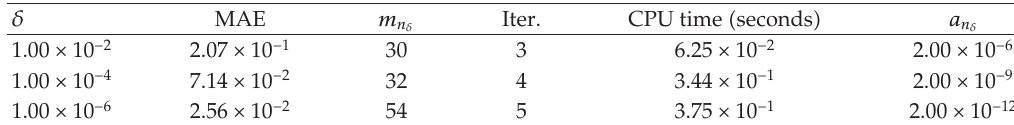
Table 9: Example